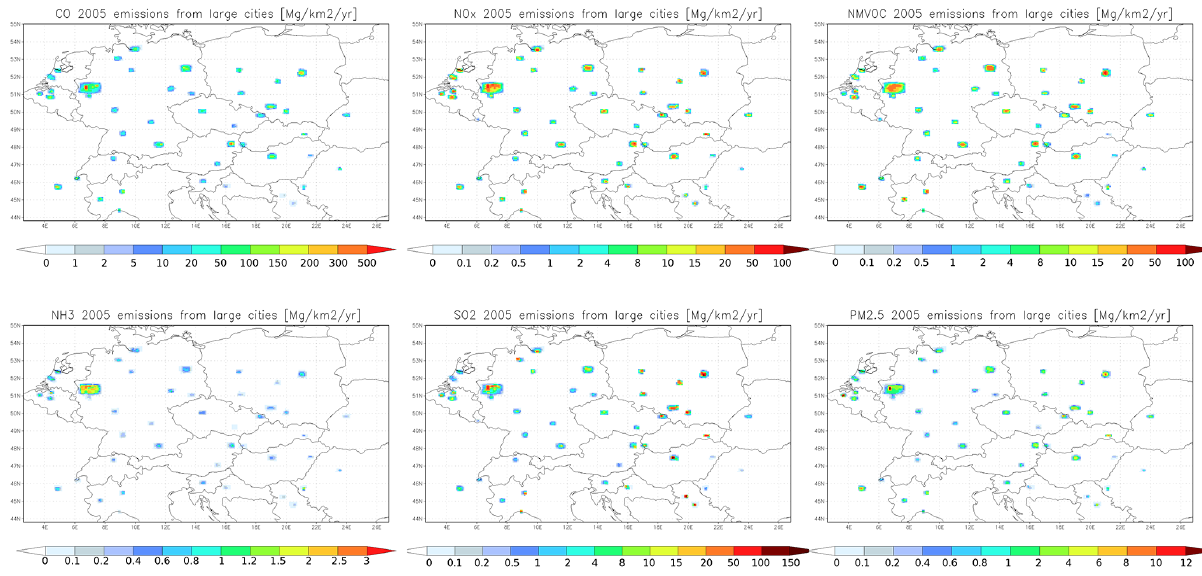
Figure 1. Annual emissions from the cities considered in the study based on the TNO MEGAPOLI 2005 emissions as Mgkm − 2 yr − 1 for CO, NO x , NMVOC, NH 3 , SO 2 and PM 2 . 5